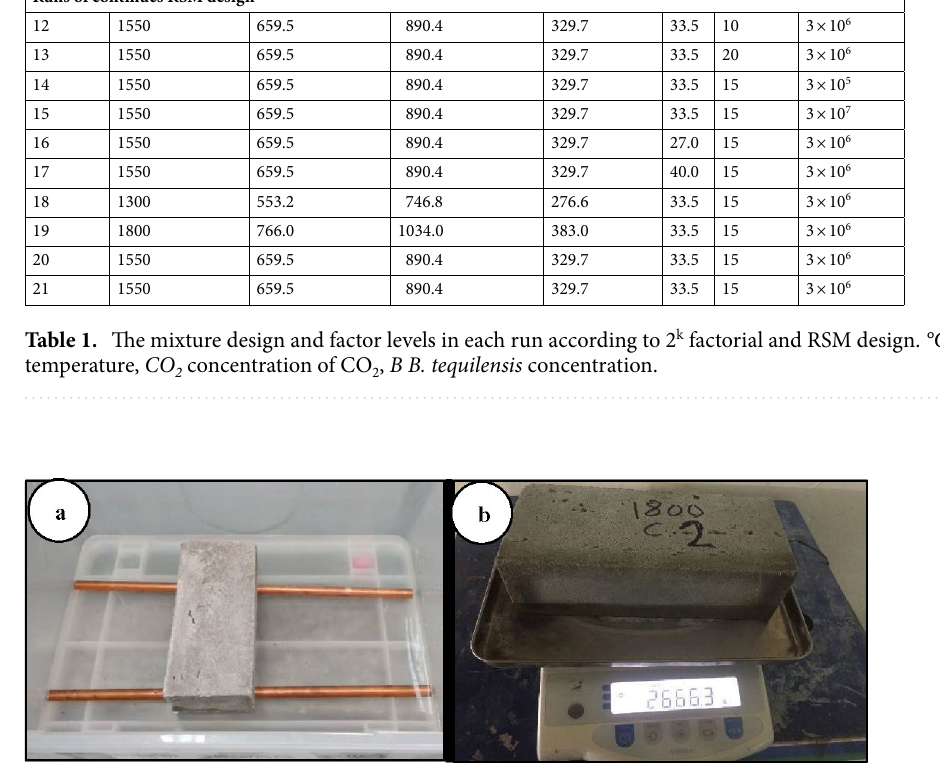
Figure 3. The initial rate of water absorption test. ( a ) Initial water absorption in 1 min. ( b ) The weight of wet